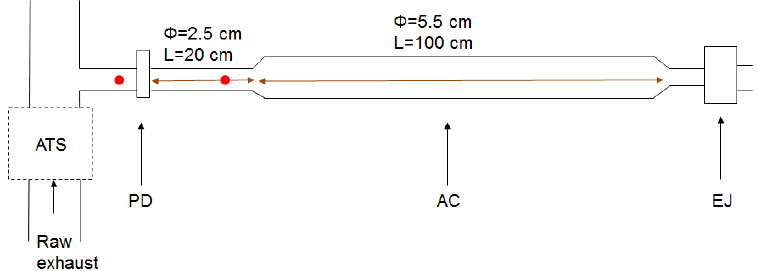
Figure 1. Schematic figure of diluting and ageing exhaust. ATS = after-treatment system, PD = porous diluter (12 : 1), AC = ageing chamber with the volume of 2.4dm 3 , EJ = ejector diluter (8 : 1). Red circles refer to temperature measurements. Exhaust flow rate through the dilution/sampling system was kept constant 55Lmin − 1